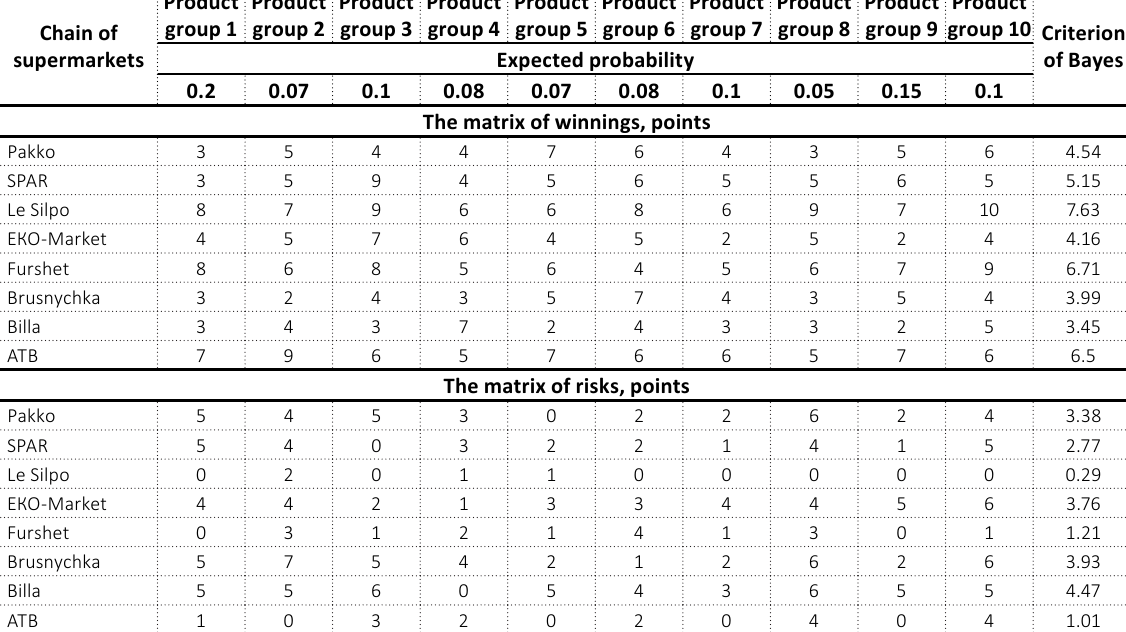
Table 3. Decision on selecting the main channels of distributing canned vegetable produce by the complex effect of the marketing mix (“4P”)